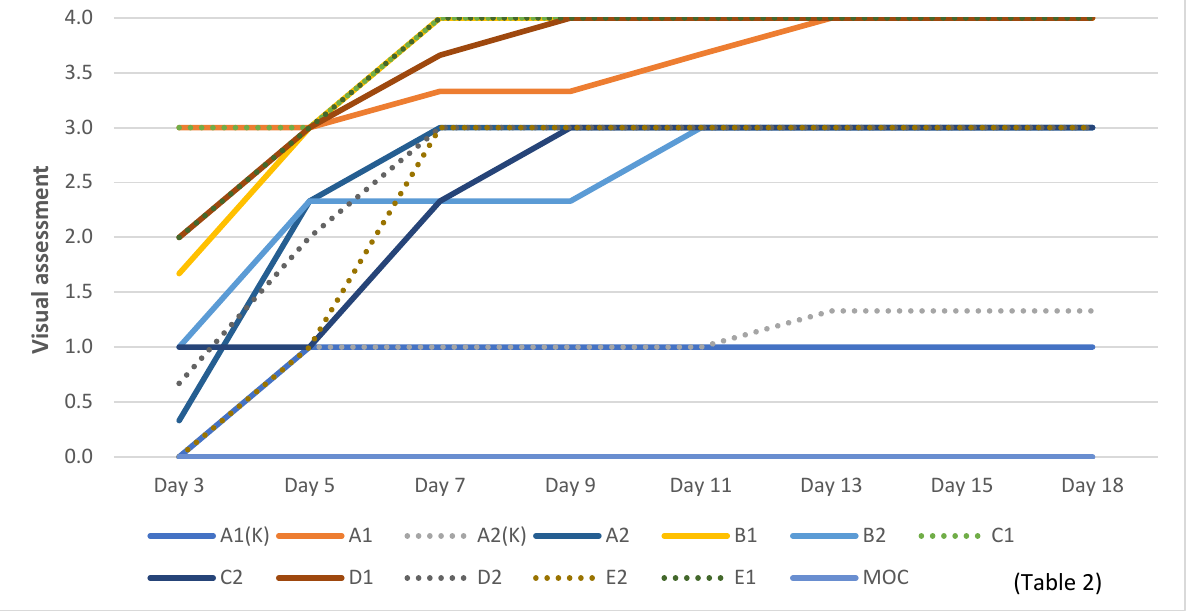
Figure 8. Rate of fungal spread in samples.